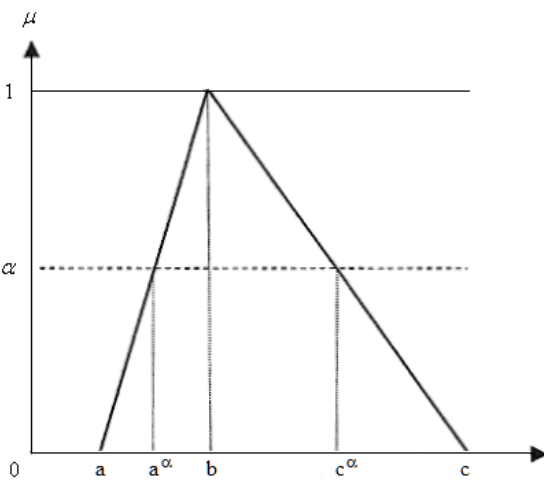
Fig. 2. Representation of a sample by triangular fuzzy